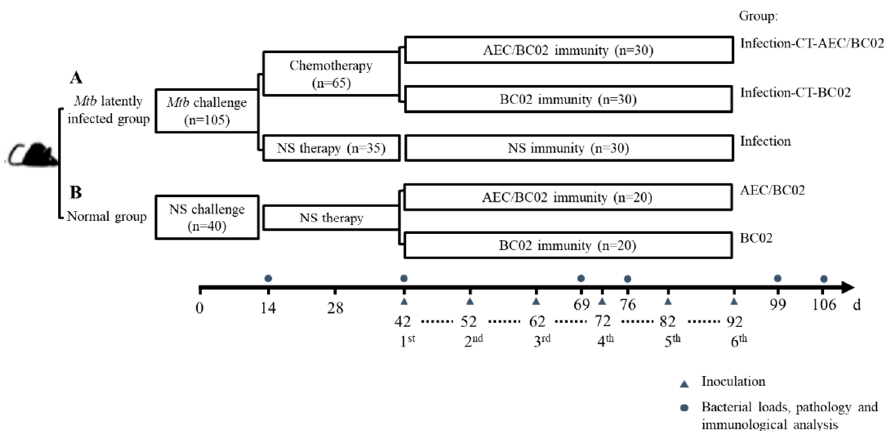
Figure 1. Immunotherapy schedule for evaluation of a potential vaccine candidate in a Mtb latently infected mouse model. Mice were randomly divided into groups A and B. ( A ) For Mtb latently infected group: mice were intraperitoneally challenged with 5 × 10 5 CFU of Mtb (t = 0 day), followed by chemotherapeutic treatment twice a week for 4 weeks (2 weeks after challenge) or NS as an infection control. ( B ) Normal group: mice were injected and treated with NS on days 0 and 14. Except for the infection control group of group A that was not immunized, the other mice were separately inoculated with one dose of AEC/BC02 and BC02 six times at 10-day intervals. Mice in all groups were euthanized at 14, 42, 69, 76, 99, or 106 days for immunological, bacterial load, and pathological analysis.